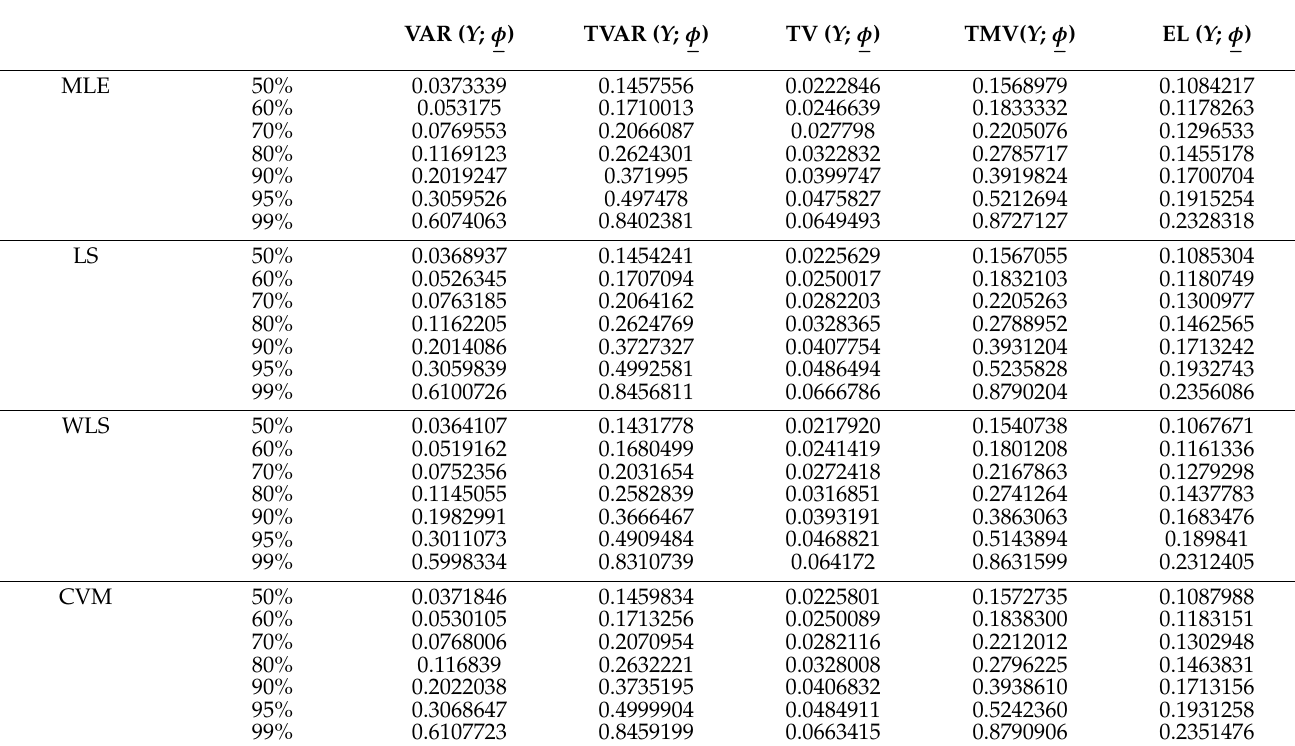
Table 9. The KRIs for the GRR-RW under artificial data where n =